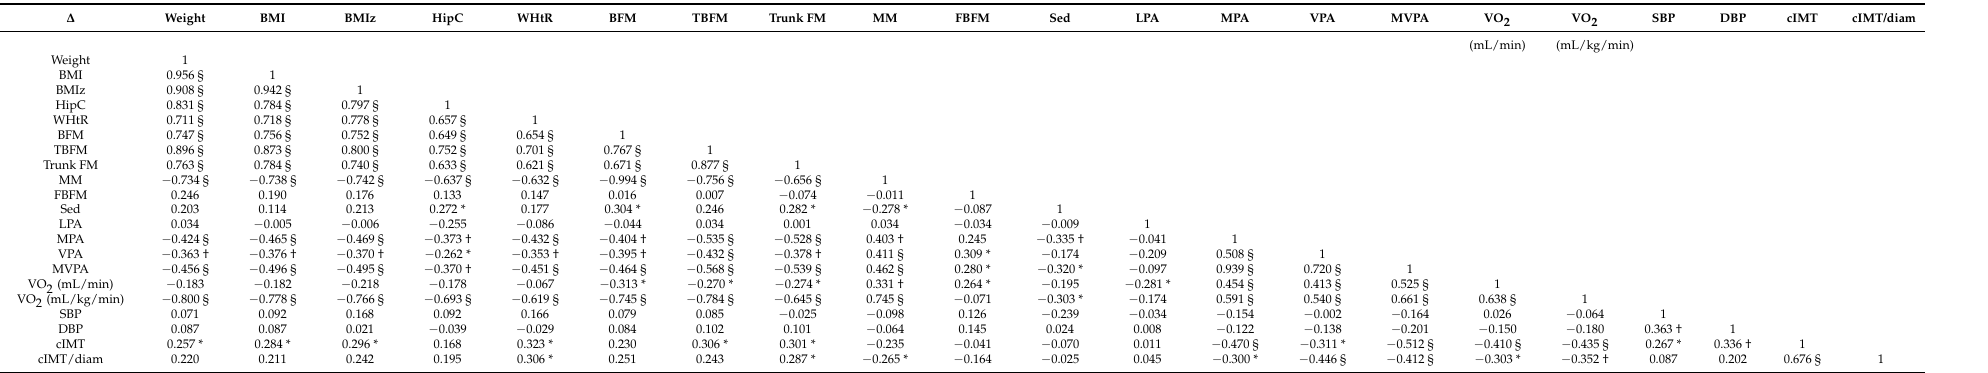
Table 3. Partial correlations controlled for sex and Tanner